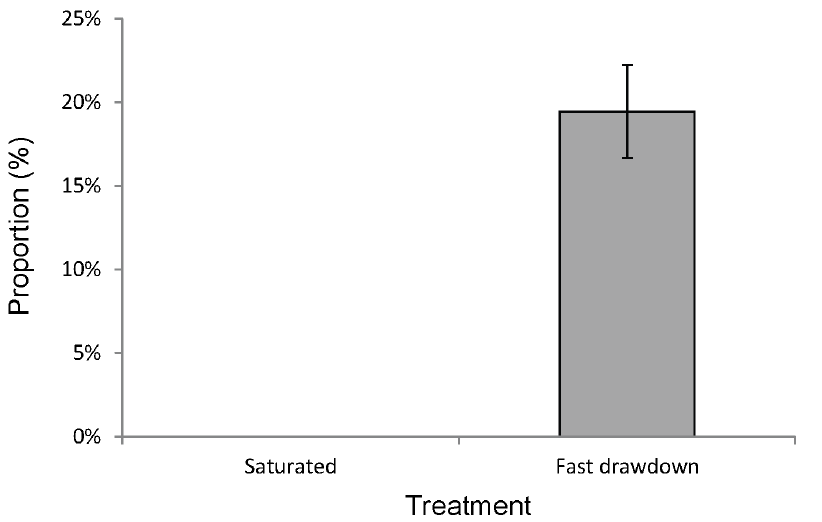
Figure 2. Mean ( ± 95% CI) proportion of syncarids in the top four centimetres of the sediment. Comparison of results on mean proportion of syncarids in the saturated and fast-drawdown columns; in the latter the top four centimetres represents the unsaturated zone in the fast drawdown columns and shows the proportion of animals stranded above the water table as the water level is lowered.